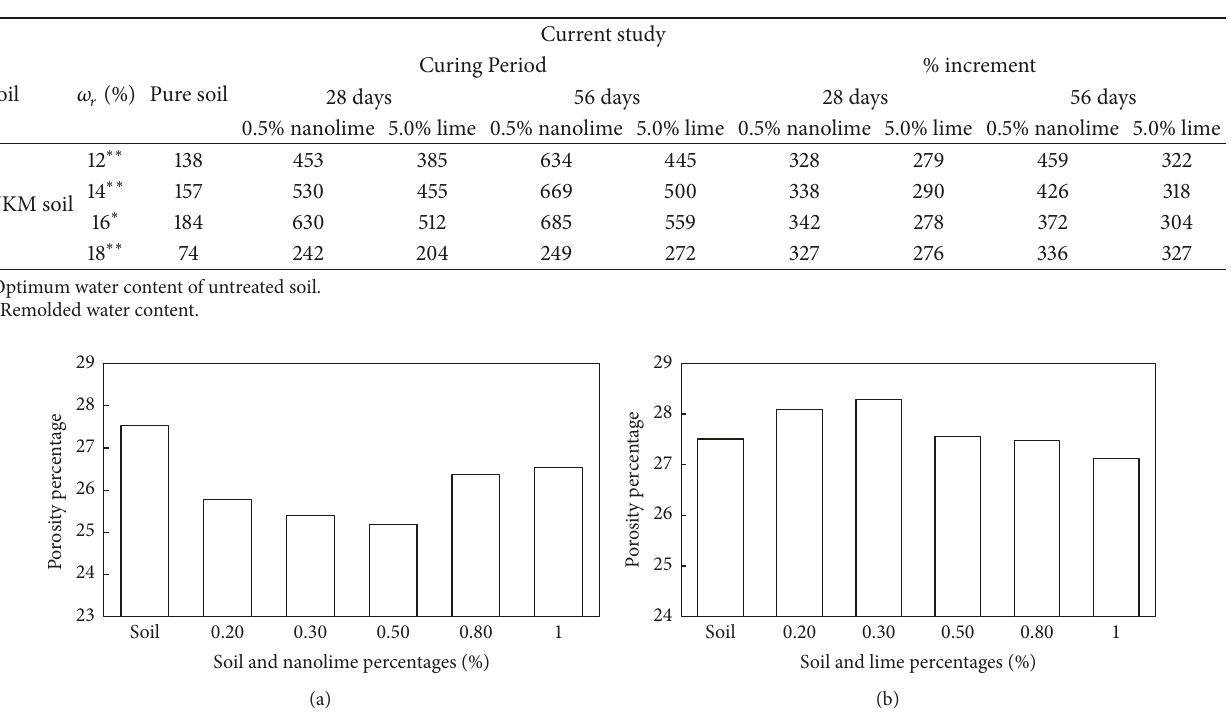
Table 6: UCS (kN/m 2 ) value from current study. Current study